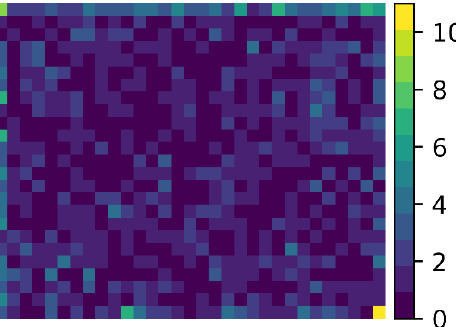
Figure 6. Heatmap of the image location for the additional CTC segmented by StarDist. Heat map of 25 × 31 bins displaying the number of additional CTC segmented by StarDist for each bin. Heat map shows an increased concentration of events on the left and top edges of the image.